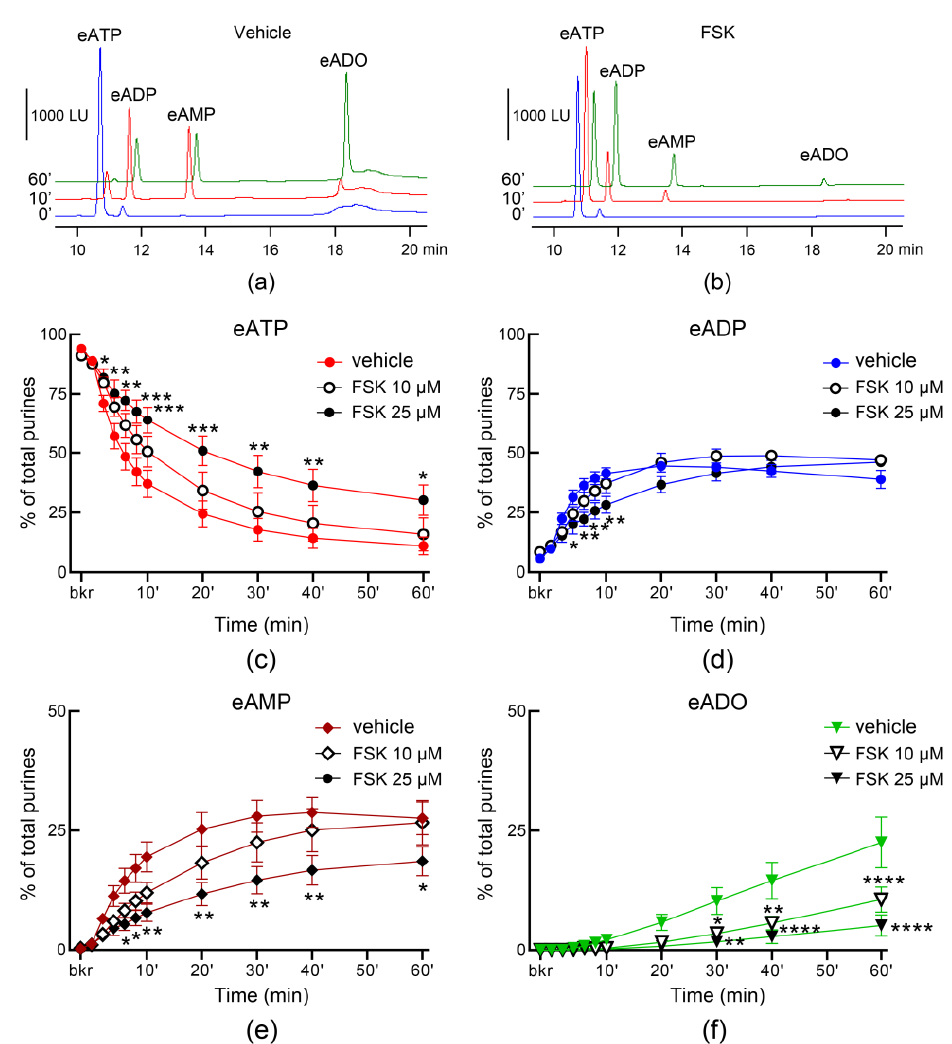
Figure 8. Effect of FSK on the hydrolysis of eATP by soluble enzymes released in the bladder lamina propria. Original chromatograms of eATP in beaker (blue, 0′), at 10 min (red), and at 60 min (green) after addition of eATP to concentrated ELS collected at the end of bladder filling in the presence of vehicle (DMSO 0.1%) ( a ) or FSK (25 µ M) ( b ). Summarized data showing time-courses of eATP decrease ( c ), eADP increase ( d ), eAMP increase ( e ), and eADO increase ( f ) in the presence of vehicle (DMSO 0.1%, n = 7) or FSK ( n = 4 each); n , number of bladder preparations. Note that the degradation of eATP was reduced in the presence of FSK. * p < 0.05, ** p < 0.01, *** p < 0.001, **** p < 0.0001 vs. vehicle controls. 2 way ANOVA with Tukey’s multiple comparisons tests.